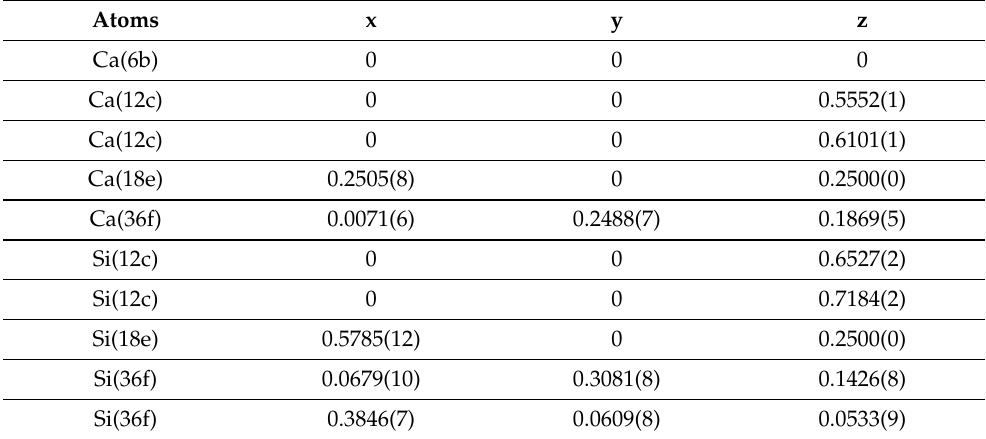
Table 2. Fractional positions of Ca 14 Si 19 specimen 2 after RSPS processing determined from Rietveld fitting analysis of the X-ray diffraction